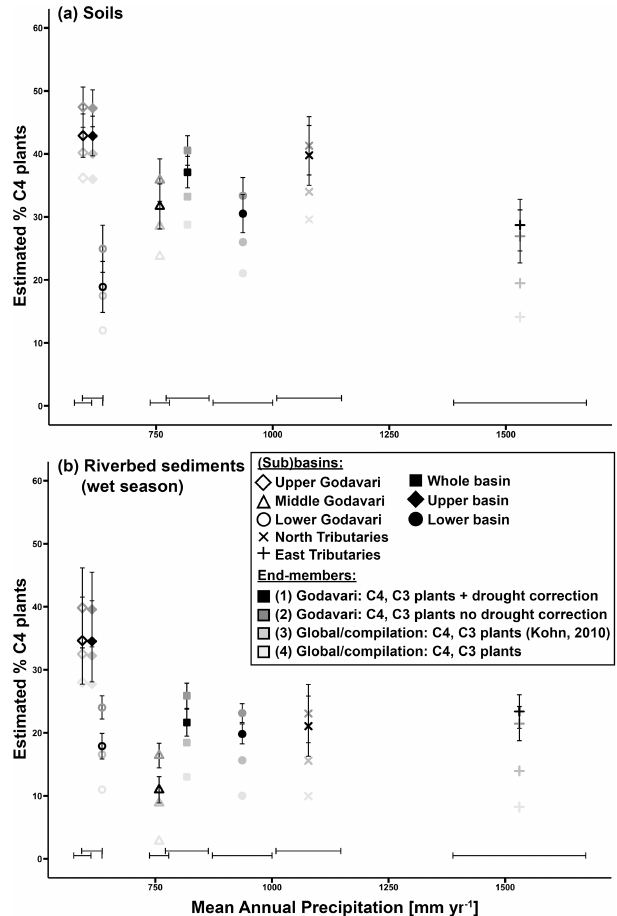
Figure 7. The estimated proportion (%) of C 4 plants determined by a linear mixing model (by Phillips and Gregg, 2001) vs. MAP for different (sub)basins, based the OC-weighted δ 13 C org signal in (a) soils and (b) riverbed sediments collected in the wet season. The whiskers represent ± standard error (SE). Four scenarios are included: (1) Godavari C 4 and C 3 plant end-members, with drought correction of C 3 plant δ 13 C; (2) Godavari C 4 and C 3 end-members, with no drought correction of C 3 plant δ 13 C; (3) C 4 and C 3 (based on Kohn, 2010) plant end-members based on compilations of global vegetation; and (4) C 4 and C 3 plant end-members as commonly quoted in literature (e.g. Cerling et al., 1997; Koch, 1998; Dawson et al., 2002) based on global vegetation (see Table 1). For scenario (2) the mean δ 13 C value for Godavari C 3 plants with no drought stress (i.e. − 29 . 3‰) was determined at a MAP of 1750mmyr − 1 using Eq. 7 (see Fig.